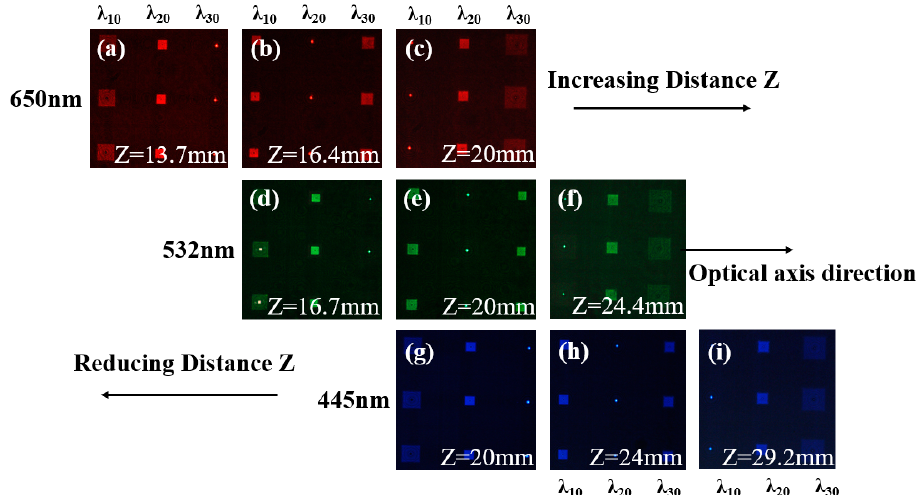
Figure 6. The spot distributions of red, green and blue laser after multi-spectral compound eye structure: ( a – c ) are the spots at the distance of 13.7 mm, 16.4 mm and 20 mm when the red laser beam with the wavelength of 650 nm irradiates through the structure, respectively; ( d – f ) are the spots at the distance of 16.7 mm, 20 mm and 24.4 mm when the green laser beam with the wavelength of 532 nm irradiates through the structure, respectively; ( g – i ) are the spots at the distance of 20 mm, 24 mm and 29.2 mm when the blue laser beam with the wavelength of 445 nm irradiates through the structure, respectively.